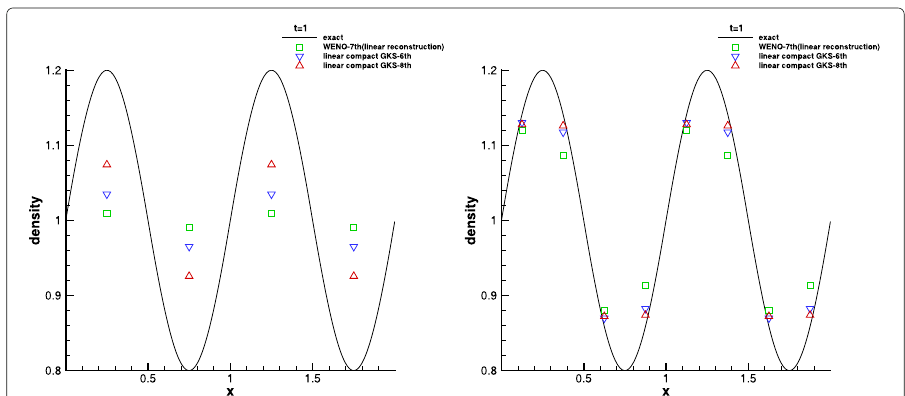
Fig. 3 Limit resolution for linear wave: Results of WENO-7th scheme with linear reconstruction and GKS flux, linear compact 6th-order and 8th-order schemes on the meshes with (cid:10) x = 1 / 2 and (cid:10) x = 1 / 4 at t = 1. Since there are only two points for each wavelength on the left figure, the real "exact" solution should be averaged over half wave length as